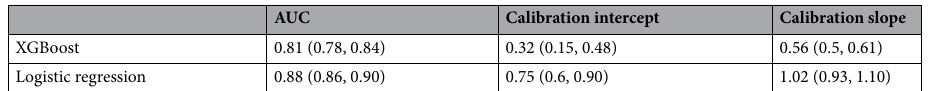
Table 2. Discrimination and calibration for predicting exacerbation within 2 days (validation cohort). XGBoost gradient boosted decision trees, AUC area under the receiver operating characteristics